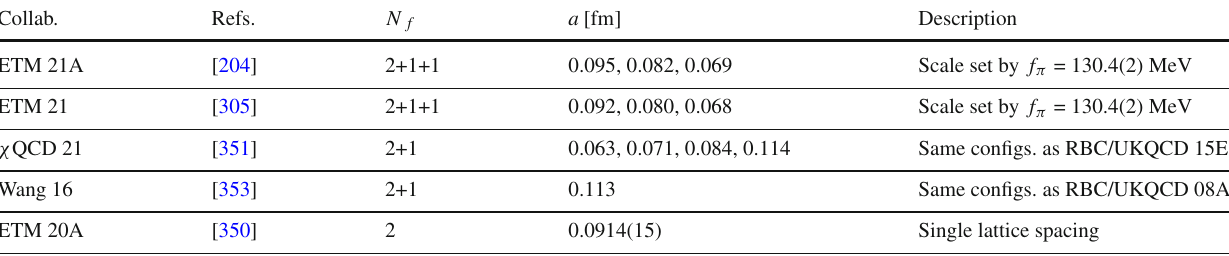
Table 109 Continuum extrapolations/estimation of lattice artifacts in determinations of the SU ( 2 ) low-energy constants (cid:13), F , ¯ (cid:6) 4 , ¯ (cid:6) 6 , and SU ( 3 ) low-energy constants (cid:13) 0 , F 0 Collab.